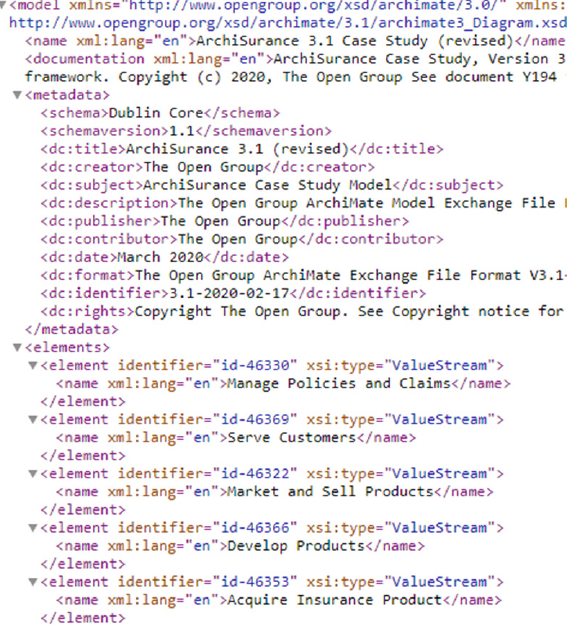
Figure 6. One section of the case repository exchange file in an XML viewer.